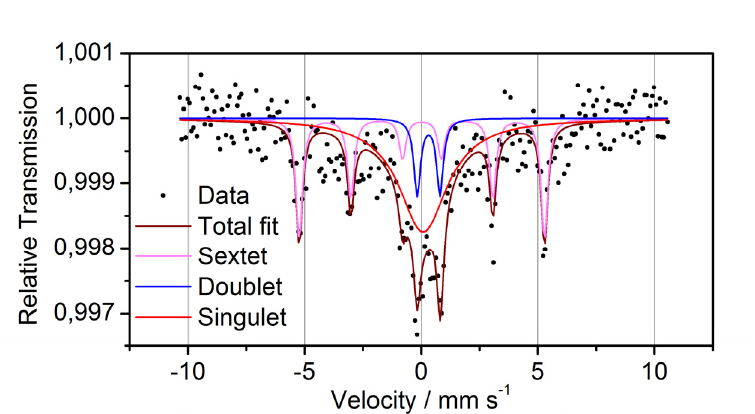
Figure 6. Mössbauer spectra and fitting subspectra for powder